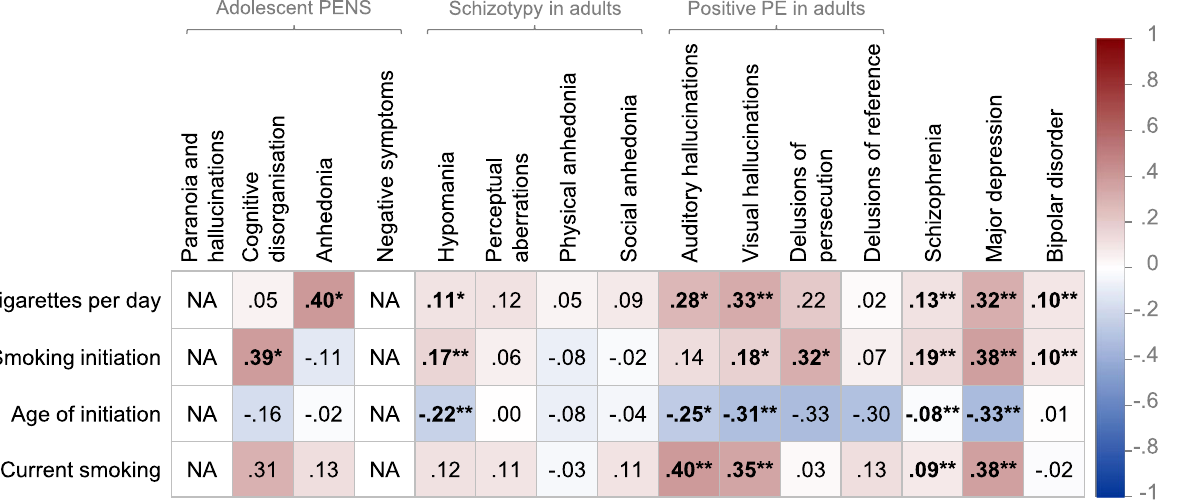
Figure 1. Heat map showing genetic correlations between smoking behaviours, psychotic experiences and psychiatric disorders. PENS Psychotic experiences (PE) and negative symptom traits; NA indicates that genetic correlations could not be computed due to low SNP-heritability or sample size; *indicates statistically significant genetic correlations at p < .05; **indicates significance at FDR < .05 using Benjamini–Hochberg correction for 60 tests; Genetic correlations reported using unconstrained LD score regression intercept between phenotypes with sample overlap (for example, smoking behaviour and major depression GWASs contained participants from the UK Biobank, and smoking behaviours and adolescent PENS contained participants from ALSPAC). Note that age of smoking initiation was coded in the direction of lower scores reflecting younger ages of initiation. Note that current smoking cases are current smokers (compared to